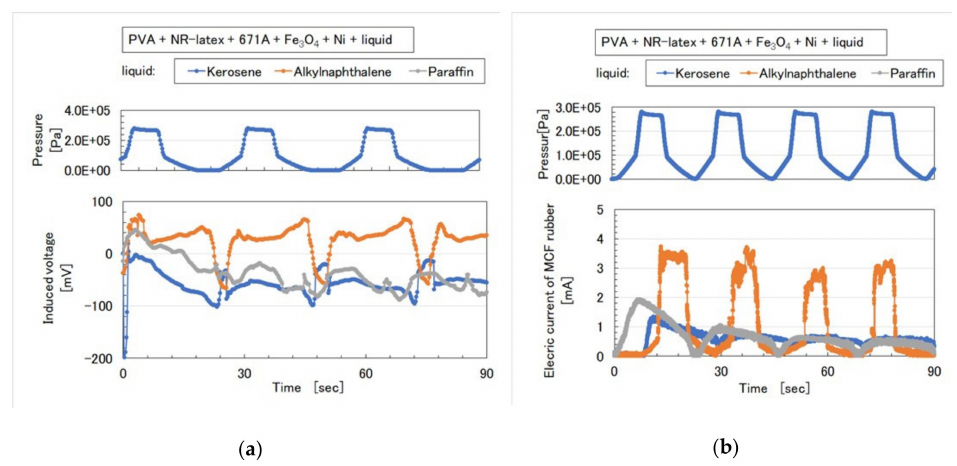
Figure 9. Induced voltage and electric current as piezo-resistivity of MCF rubber with water-insoluble liquid to repeat pressure application in Figure 6: ( a ) piezo-electricity; ( b ) piezo-resistivity.